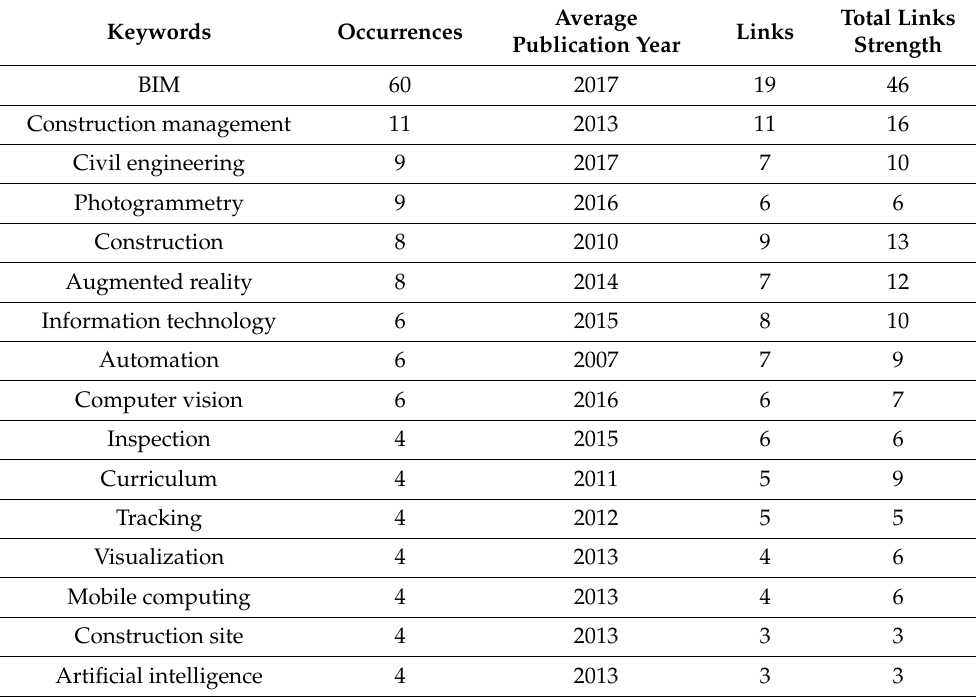
Table 3. Top keywords of research interest on DTs in the AEC